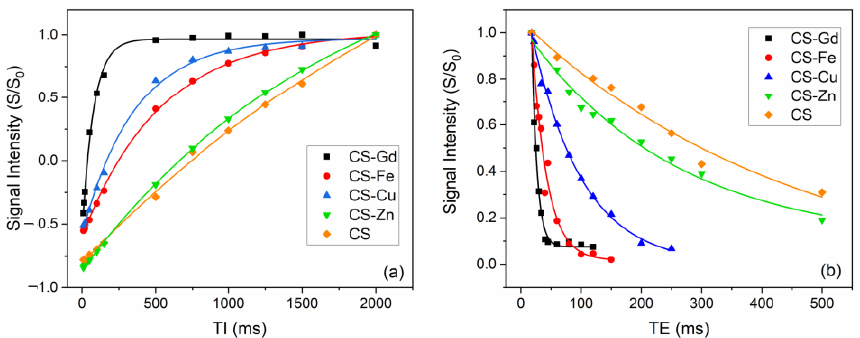
Figure 7. Time evolution of normalized signal intensities read on set of MRI images of CS–metal and CS microgel suspensions obtained with ( a ) inversion recovery (IR) and ( b ) spin echo (SE) sequences (see Supplementary Figure). Solid lines show mono exponential fits using Equations (2) and (3).